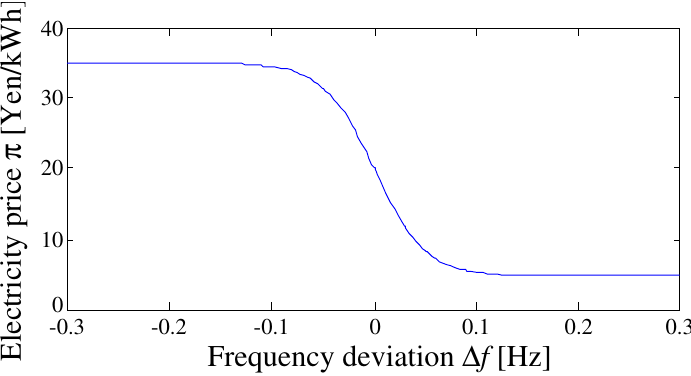
Figure 10. Electricity price π for frequency deviation ∆ f .